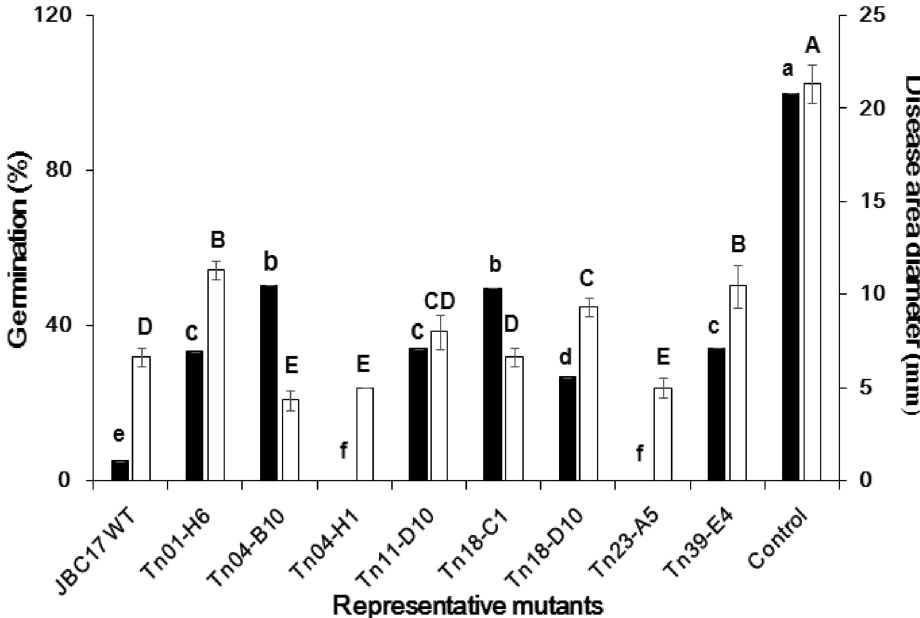
Figure 1. Effect of Tn mutation on conidial germination and biocontrol activity of Pseudomonas putida JBC17 and its Tn mutants. For the conidial germination inhibition assay, the conidia of Penicillium digitatum were incubated with P. putida JBC17 (JBC17WT) or each mutant strain, and germination was observed with a light microscope 24 h after incubation at 25 °C. For the biocontrol assay, mandarin fruits were wound-inoculated with a conidial suspension of P. digitatum followed by treatment with bacterial suspensions of JBC17WT or its mutants. The disease area (mm) was assessed 7 d after incubation at 20 °C and 90% relative humidity. The data represent the mean ± standard deviation, and bars with the same letter(s) do not differ significantly at P <